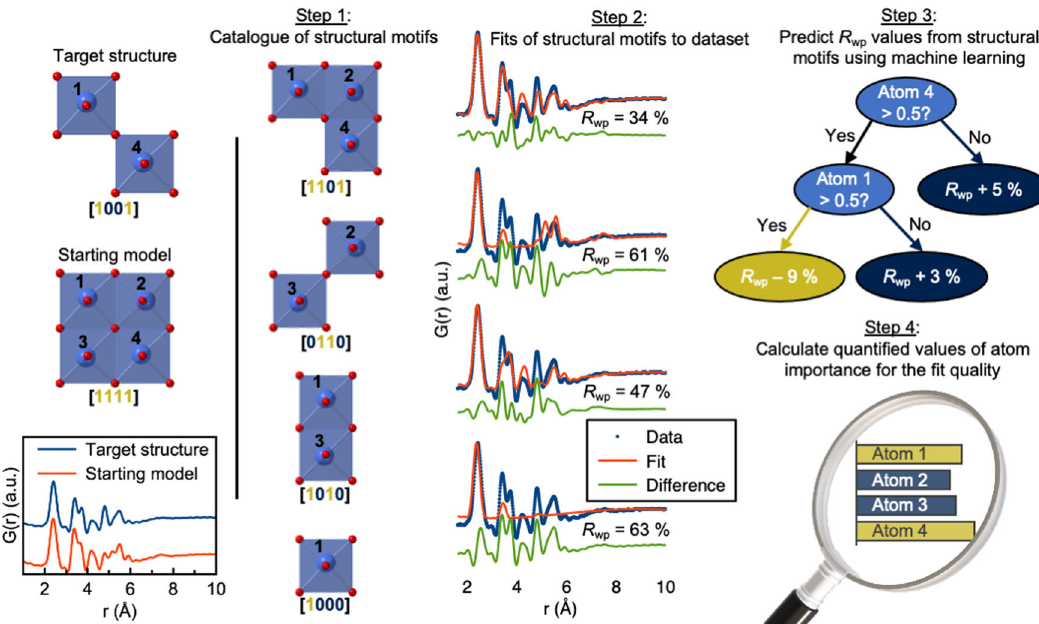
Fig. 1 Illustration of the ML-MotEx process. Firstly, a starting model is provided. Using this starting model, a structure catalogue is generated, and the structures in the catalogue are fi tted to the experimental data in question. An ML algorithm is then trained to predict R wp values and fi nally calculating quanti fi ed values of feature importance for the fi t